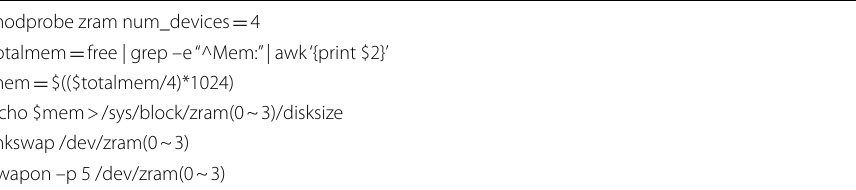
Table 3 Setting value of